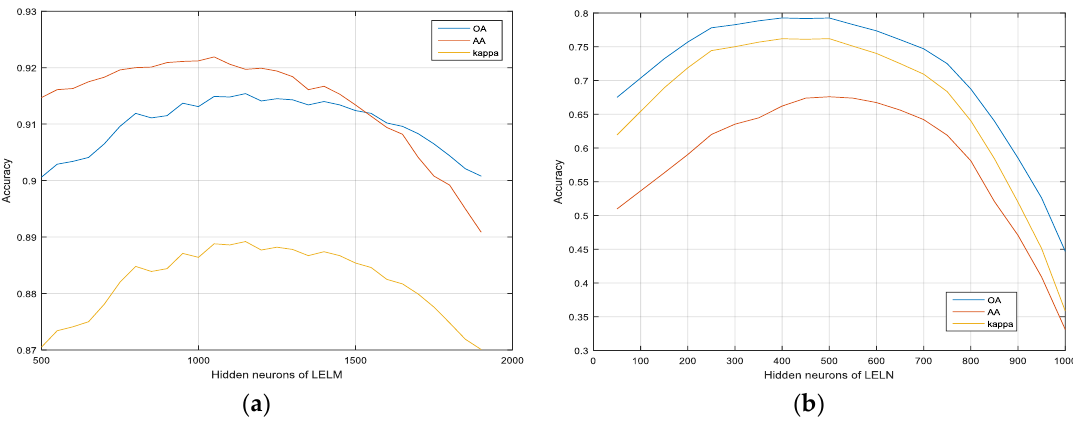
Figure 3. The impact of hidden neurons of ELM in the datasets: ( a ) Indian Pines; ( b ) Pavia University.